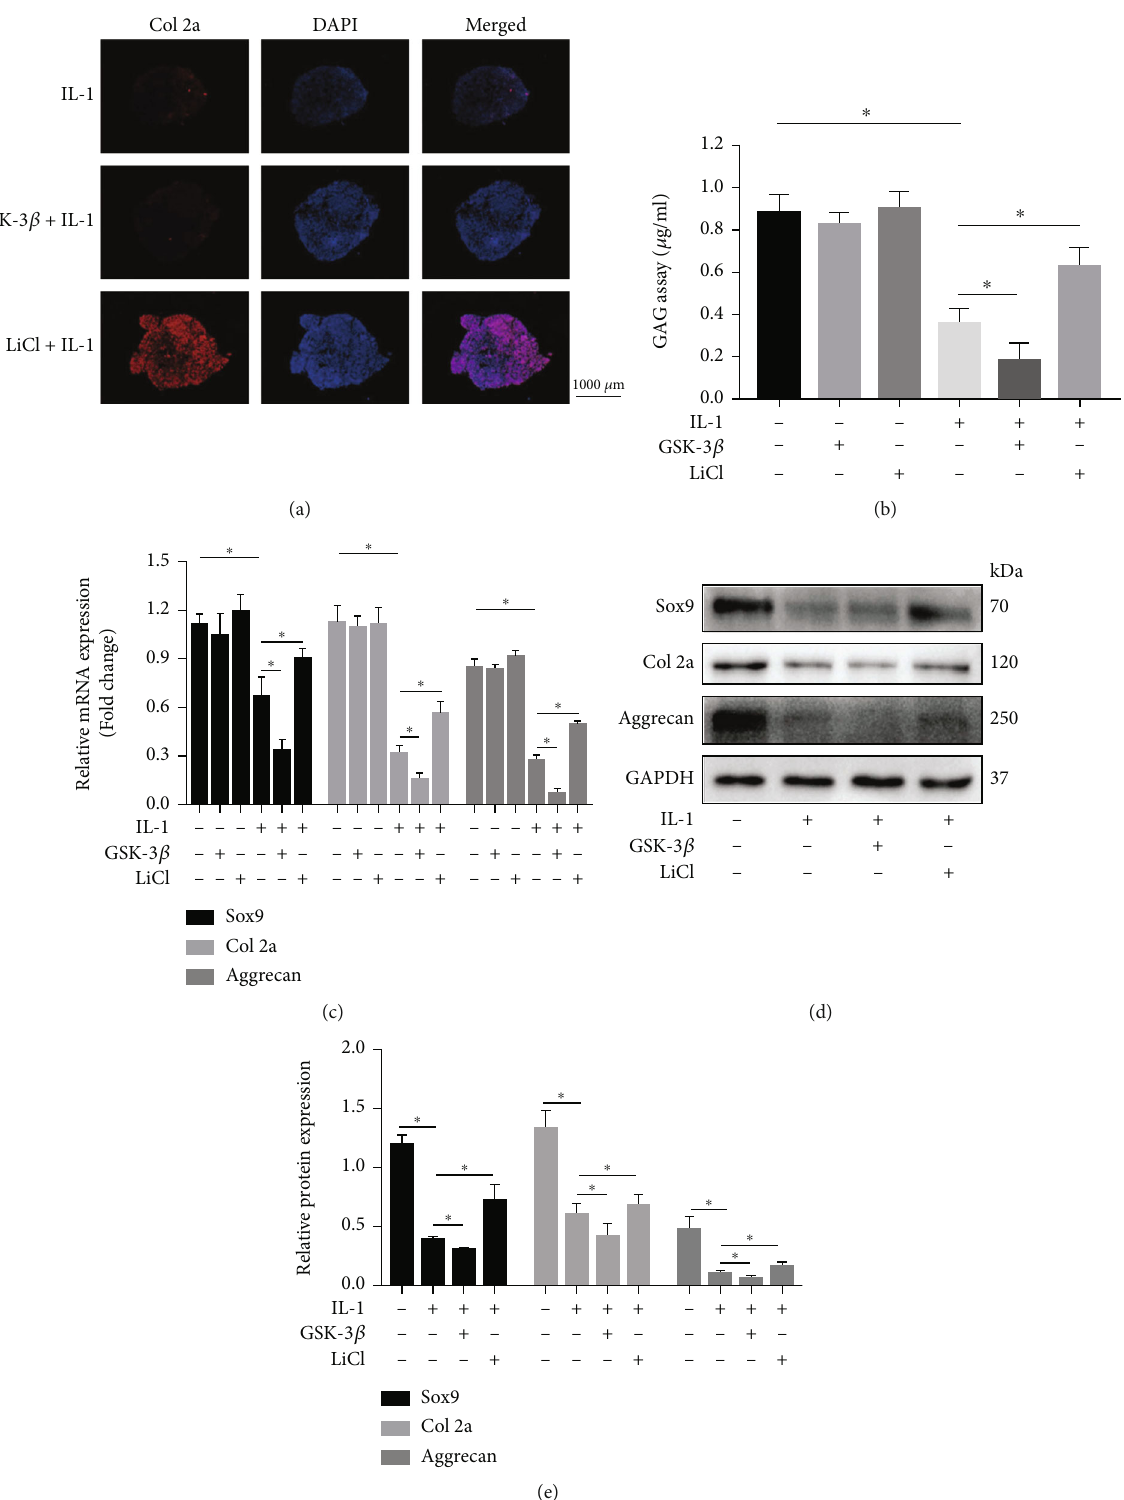
Figure 2: GSK-3 β disrupts metabolic balance of IL-1 β -impaired BMSCs. (a) Representative immuno fl uorescence images of collagen 2a. (b) The GAG content in the culture medium. (c) The expression level of Sox9, C and Aggrecan were detected by qRT-PCR (c) and western blotting (d) and (e). All results are expressed as the mean ± SD ( n = 3 ). NS: not signi fi cant and ∗ P < 0 : 05 . Bar = 1000 μ